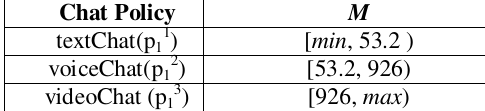
Table 3 Thresholds of Adaptation Mode for Chat